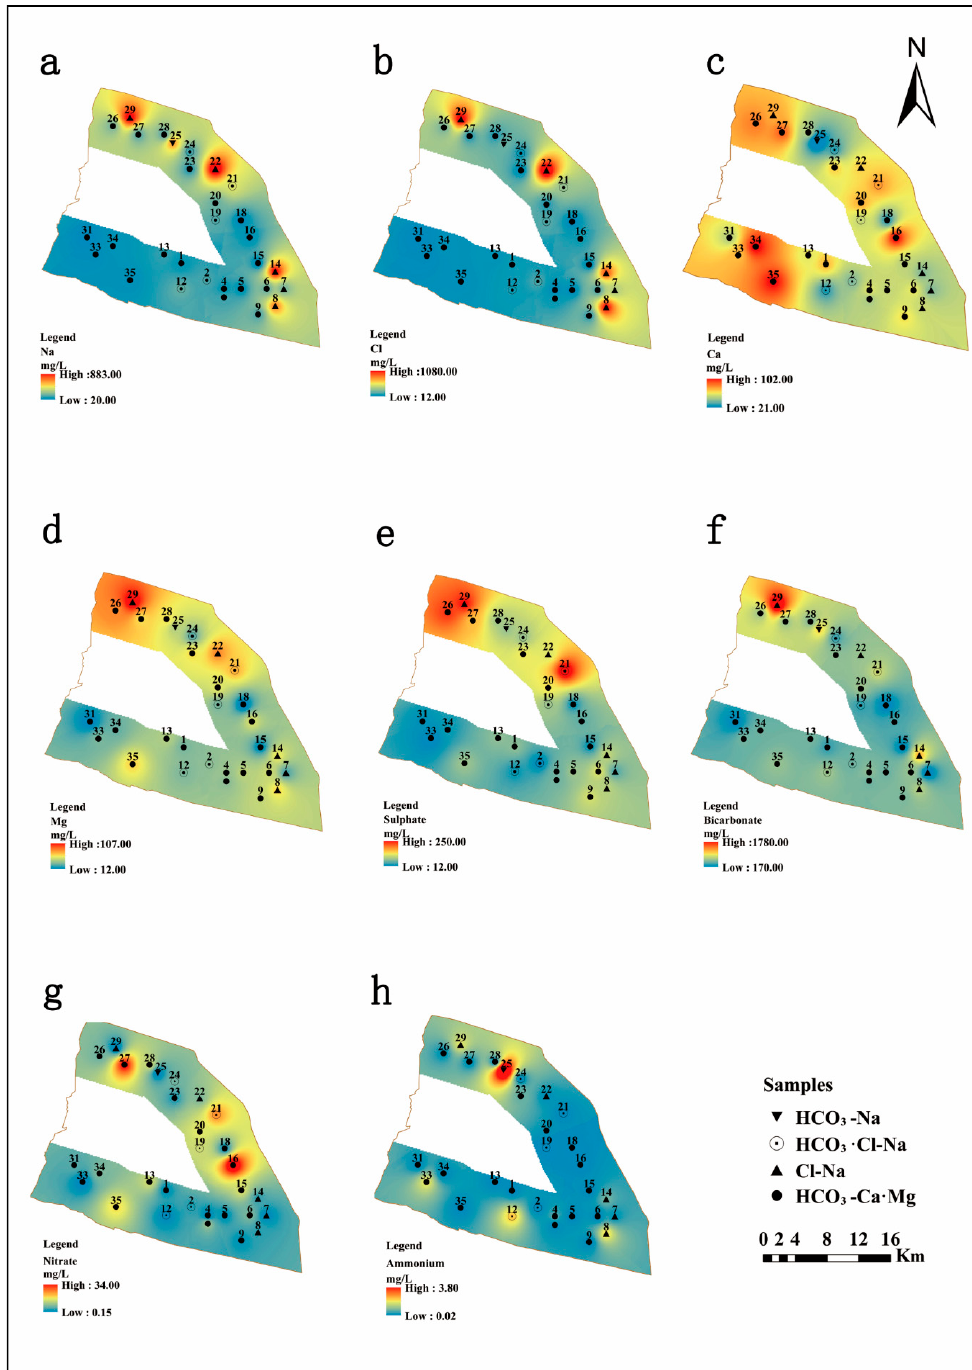
Figure 4. Spatial distribution of the major ion concentrations (mg/L) in study area: ( a ) Na, ( b ) Cl, ( c ) Ca, ( d ) Mg, ( e ) SO 42 − , ( f ) HCO 3 − , ( g ) NO 3 − , ( h ) NH 4+ .